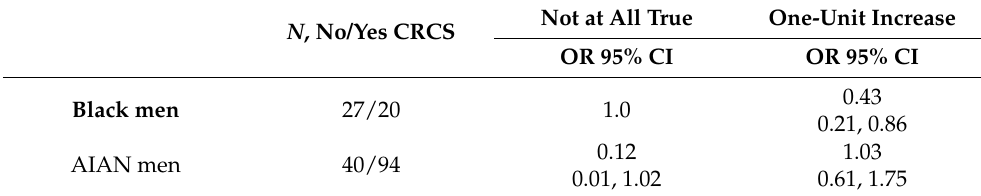
Table 4. Modification table of the effect of negative attitudes toward medical professionals and exams on ever completing a colorectal cancer screening test between Black and AIAN men (fully adjusted